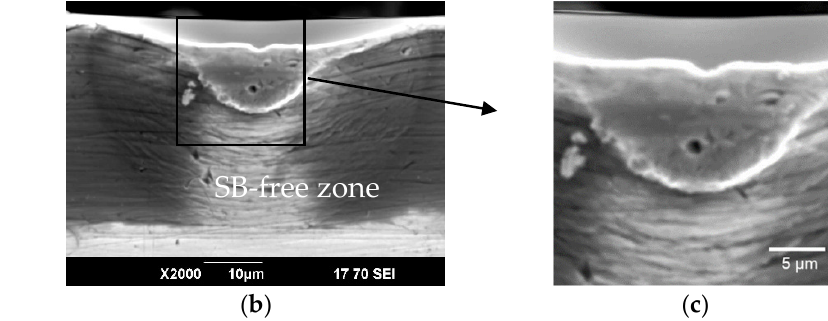
Figure 4. Bonded indentation of the tightly fixed samples of BMG Vit105 in the initial state: ( a ) top view; ( b ) deformation area on the side surface area near the indent (SEM); ( c ) same, enlarged.